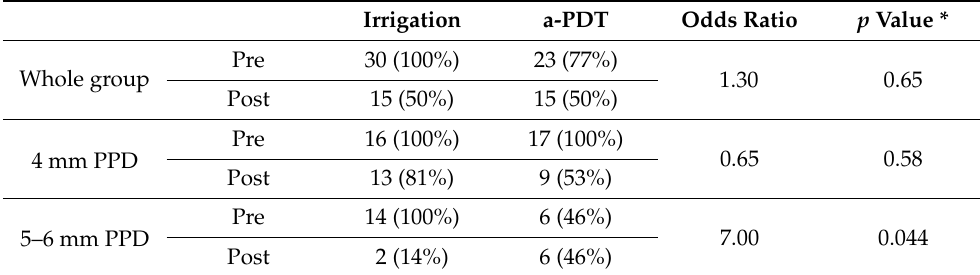
Table 3. Number of plaque retention sites before and after treatment.